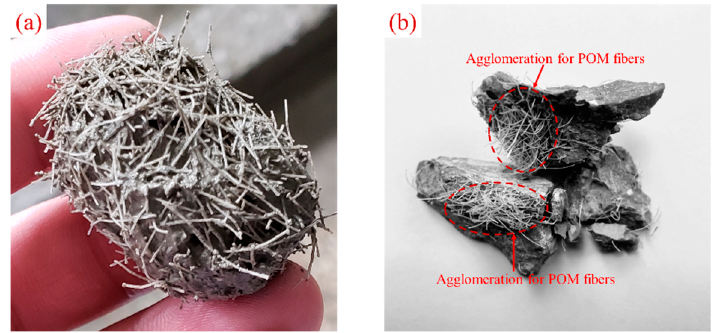
Figure 9. Agglomeration for POM 24 mm in length: ( a ) during the concrete mixing process and ( b ) after the specimens were broken.